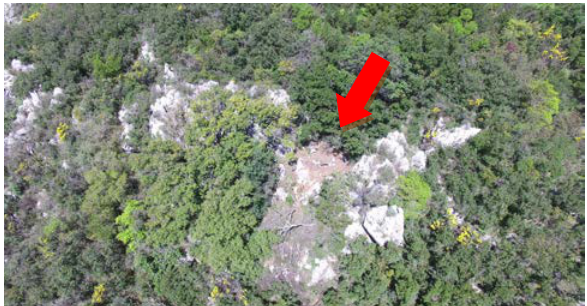
Figure 2. Aerial oblique view of rockfall